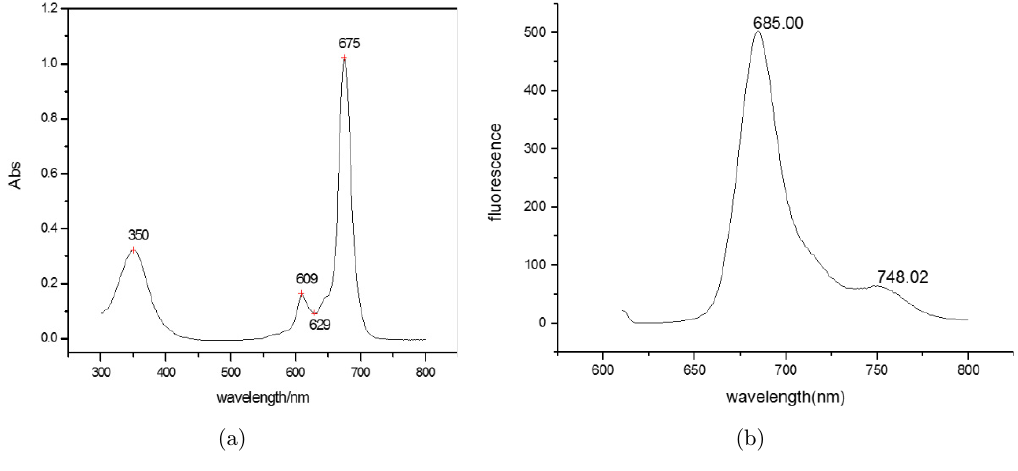
Fig. 2. (a) Absorption and (b) °uorescence spectra of Photocyanine in DMF.